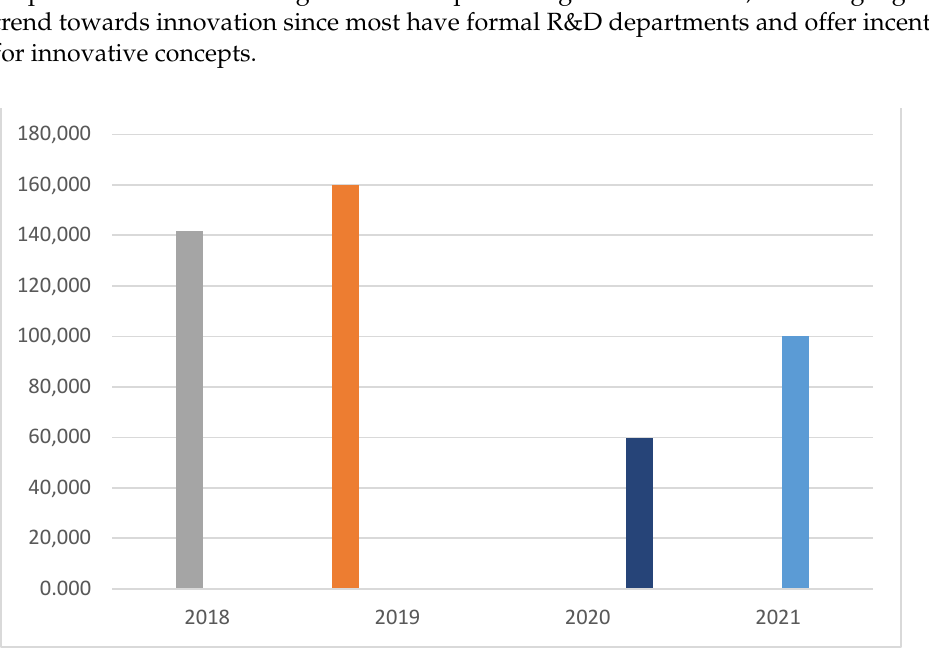
Figure 1. Contribution of tourism (millions of euros) to GDP since 2018. Source: INE (National Institute of Statistics) 22 December 2022.